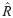
Distributions of R^ for each model.